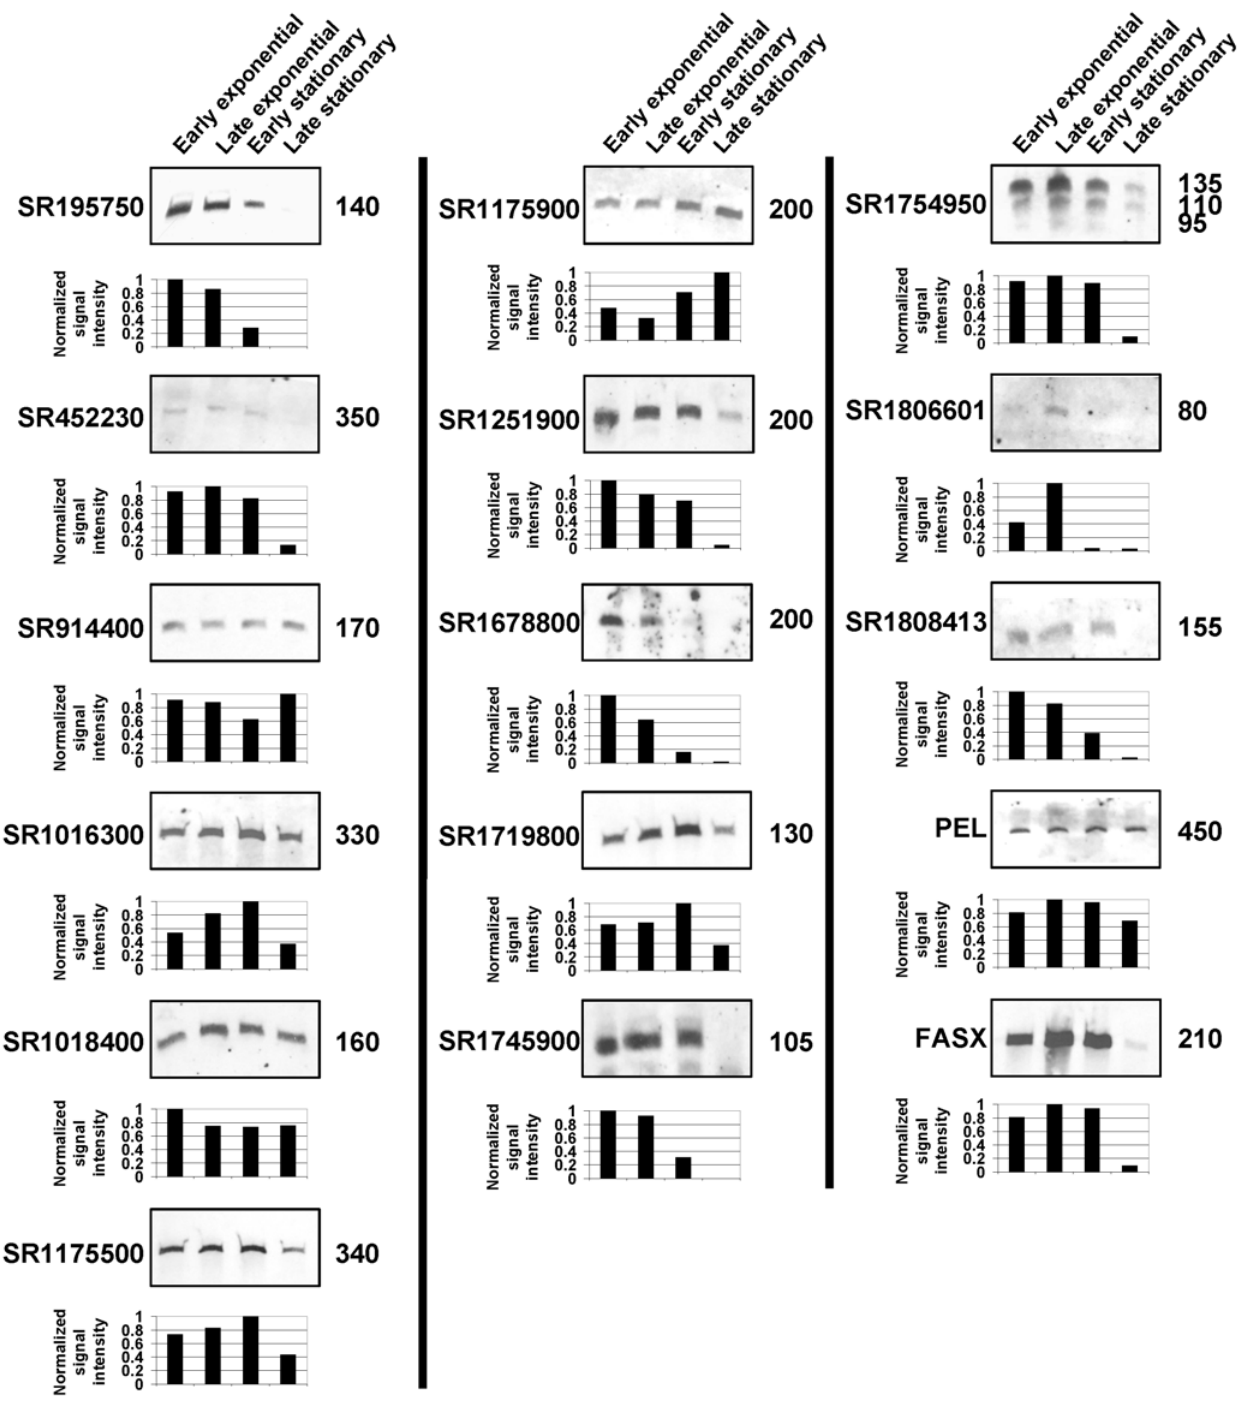
Figure 2. Northern blot verification of candidate sRNAs. Northern blots were performed using RNA isolated from strain MGAS2221 at 4 growth phases and probed for the presence of candidate sRNAs. The name or genome location (in nucleotides, relative to the published MGAS5005 genome) of candidate RNAs is displayed to the left of each blot. The approximate size in nucleotides of detected transcript/s is displayed to the right of each blot. Below each blot is a graph representing the normalized signal intensity of each hybridizing band. Signal intensities were generated using the Quantity One software package version 4.6.1., and normalized to signal detected for the housekeeping RNA 5S RNA (a representative 5S RNA blot is shown in figure 3). Normalized signal intensities are plotted relative to the most highly expressed